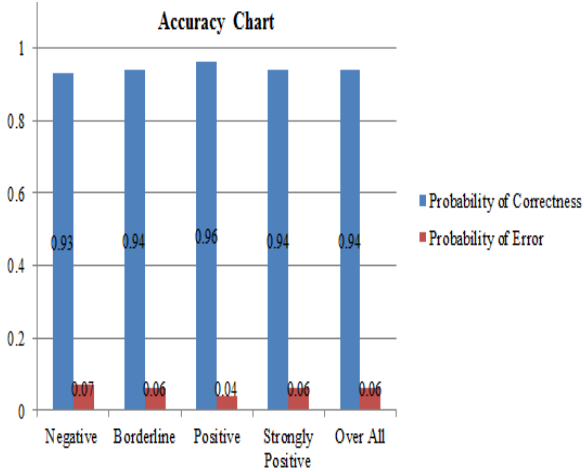
Fig. 5. Accuracy Chart of Proposed DHD-MFI expert